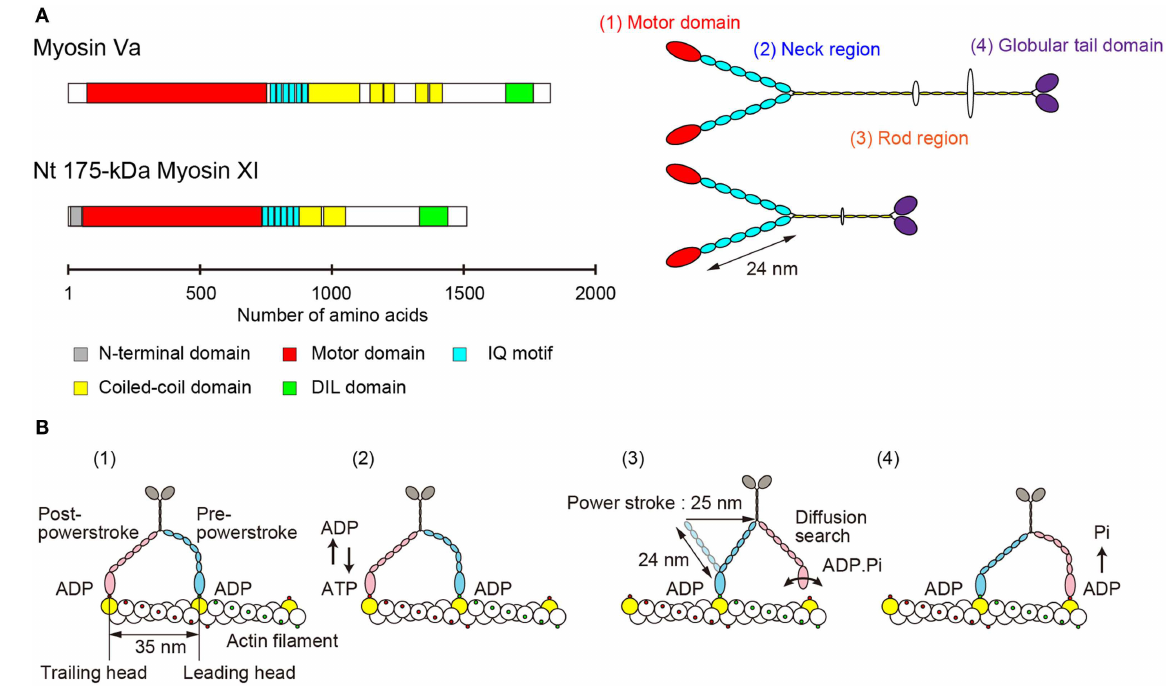
trailing head detaches from the actin filament.The strain stored in the neck domain of the leading head swings the detached head forward, generating a 25-nm power stroke.The new leading head (bound to ADP-Pi) finds a binding site 35nm forward via a diffusion search. (4) After binding to actin, the leading head rapidly releases Pi and establishes a strong binding conformation, the same state as in (1).The strain and the biased diffusion search of the detached head and its subsequent rebinding constrain the movement of a myosin molecule to a single direction, i.e., toward the plus-end of